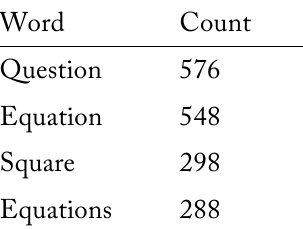
Table 6: Highest Ranking words containing the letter